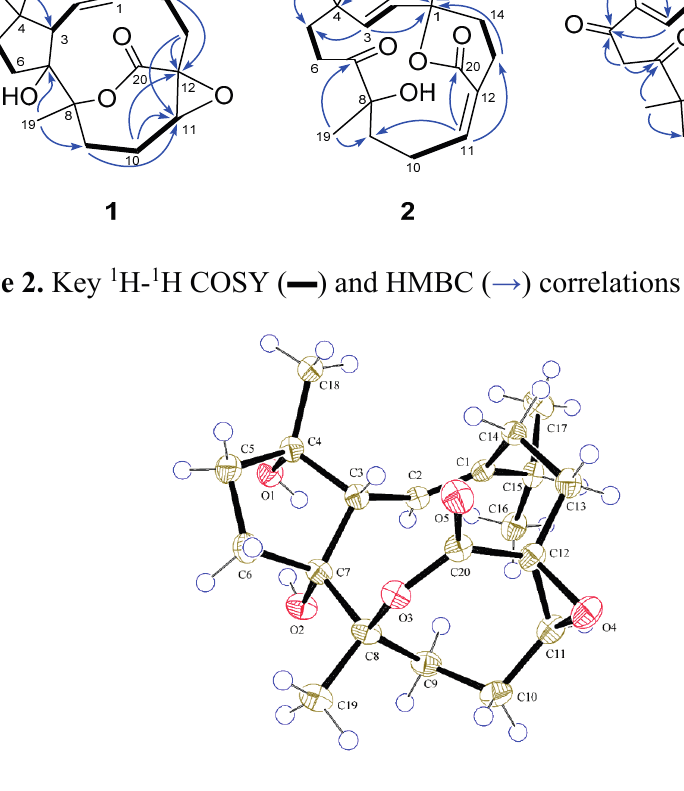
Figure 3. ORTEP depiction for X-ray crystal structures of 1